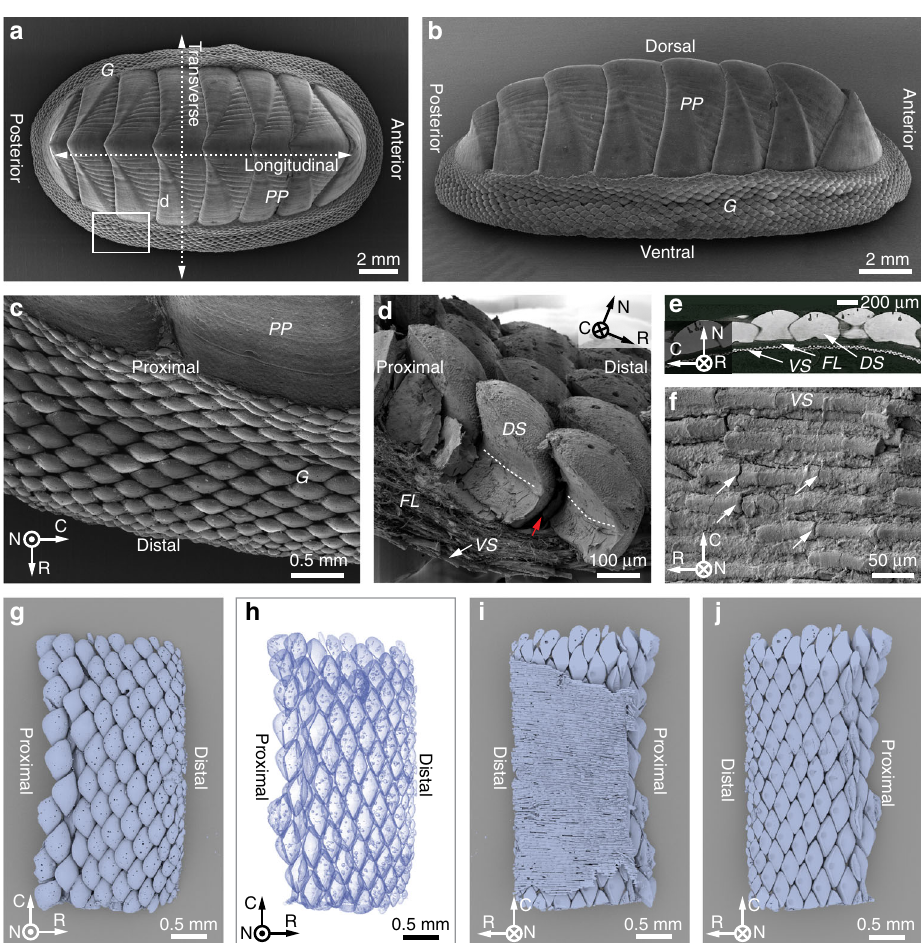
Fig. 1 Biological fl exible scaled armor in the girdle of the chiton Rhyssoplax canariensis . a , b Wide- fi eld scanning electron microscopy (SEM) images of the chiton R. canariensis , which show the dorsal and side view of the primary plates (PP) and peripheral scale-covered girdle (G), respectively. c Enlarged view of the girdle covered with dorsal scales. The image was acquired from the region indicated by the rectangular box in a , highlighting individual overlapping dorsal girdle scales, a fully covered protective armor. d Fractured cross-section of the girdle scaled armor, which consists of three components arranged from dorsal to ventral: (1) dorsal scales ( DS ); (2) fi brous layer ( FL ); and (3) ventral scales ( VS ). The white dashed lines indicate the height of the inter-scale organic matrix, and the red arrow indicates gaps between adjacent scales. e Cross-sectional view of scaled armor based on micro-computed tomography ( μ -CT ) data. Note the distance between the dorsal and ventral scale layers, which is occupied by the fi brous layer. f SEM image of the rod-shaped ventral scales, where the white arrows indicate small cracks. g – i μ -CT 3D rendering of the chiton R. canariensis girdles in different viewing orientations and modes: g top view of girdle scales, h transparency mode showing the overlapping characteristics among adjacent scales, bottom view i with and j without ventral scales. A local coordinate system is de fi ned as following: N (normal), from ventral to dorsal; R (radial), from proximal to distal;